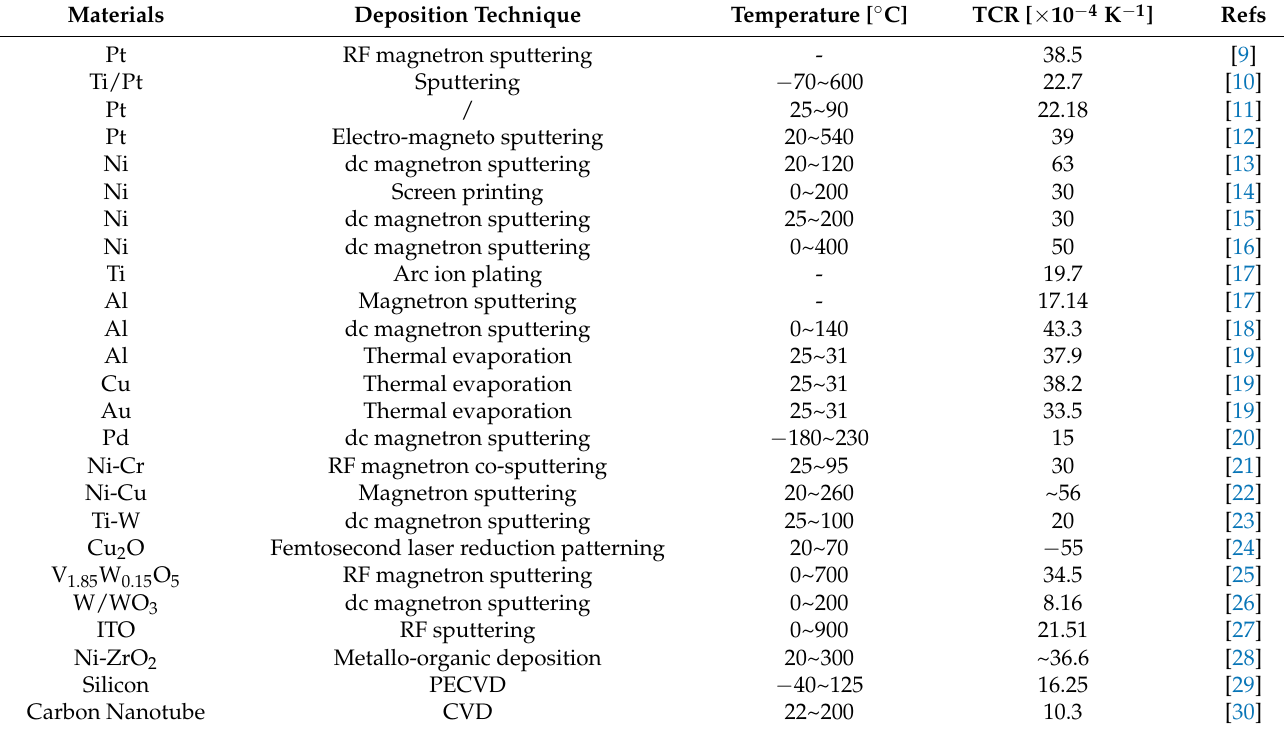
Table 1. Research status of thermal